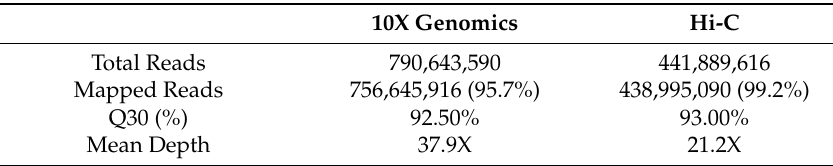
Table 1. Summary of sequencing data from the two platforms.